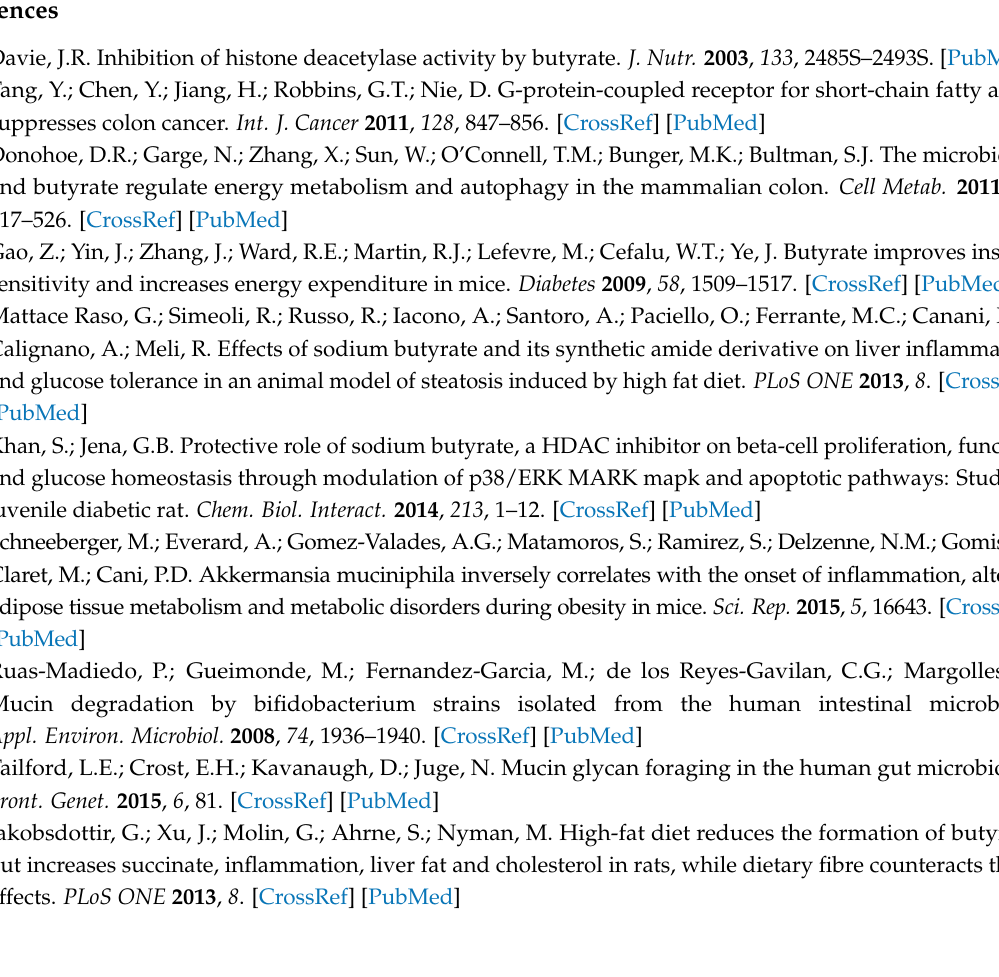
for CTL, HFD, LFD, and LPM samples, indicated C, H, L, and lpm, respectively. “_20” indicates “day 20” when samples were obtained; Figure S4: Comparison of ecological indices between constipated mice gut microbiota: (A) for species richness; (B) for species evenness. Different letters indicate significant difference according to Duncan’s multiple range test ( p < 0.05). Figure S5: Taxonomic composition comparison: (A) at the phylum; (B) at the family level. Black, red, green, and blue indicate CTL, HFD, LFD and LPM, respectively; Figure S6: Comparison of gut microbiota at day 7 and day 20. C, H, L, and lpm indicate control, high fat diet, low fiber diet, and loperamide groups, respectively. Numbers after sample names indicate day of the feeding trial. Figure S7: Significantly affected KEGG reaction modules by high-fat diet treatment; Figure S8: Significantly affected KEGG reaction modules by low-fiber diet treatment; Figure S9: Significantly affected KEGG reaction modules by loperamide treatment; Table S1: Calories of feeds used in this study. Table S2: Changes in body weight, feed intake, water intake, and fecal parameters of mice at day 21. Table S3: Average number of reads, operational taxonomic units, and structural genes for MiSeq and HiSeq. Table S4: Abundance (TPM) and taxa of CTL contigs with higher differential abundance compared to HFD. Table S5: Abundance (TPM) and taxa of HFD contigs with higher differential abundance compared to CTL; Table S6: Abundance (TPM) and taxa of CTL contigs with higher differential abundance compared to LFD; Table S7: Abundance (TPM) and taxa of LFD contigs with higher differential abundance compared to CTL; Table S8: Abundance (TPM) and taxa of CTL contigs with higher differential abundance compared to LPM; Table S9: Abundance and taxa of LPM contigs with higher differential abundance compared to